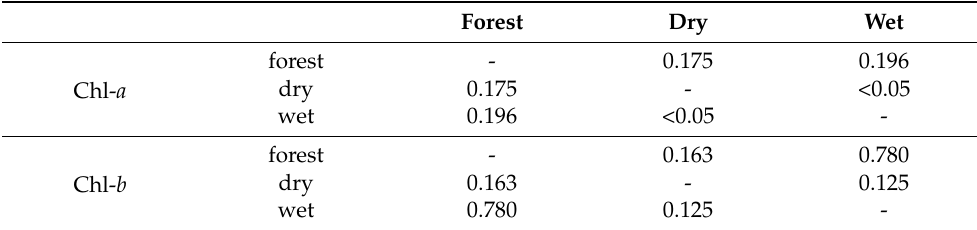
Table 2. Student’s t -test results for chlorophyll a and b content in mosses.